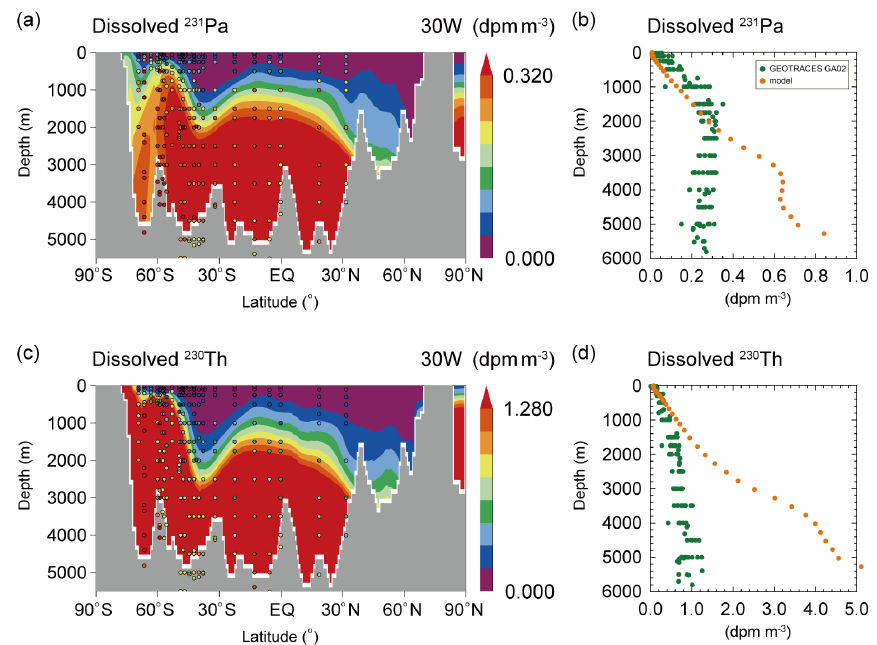
Figure 1. (a) Dissolved 231 Pa along 30 ◦ W in the Atlantic Ocean and (b) its vertical profile (the latitudinal mean along 30 ◦ W in the Atlantic Ocean) in Siddall_EXP. (c, d) Same as (a) and (b) except for 230 Th. The colored circles in (a) and (c) represent data from the Atlantic GEOTRACES data (GA02 and GIPY05; Schlitzer et al., 2018). The green and orange circles in (b) and (d) represent the GA02 data and simulation results. The unit is dpmm − 3 (disintegrations per minute per cubic